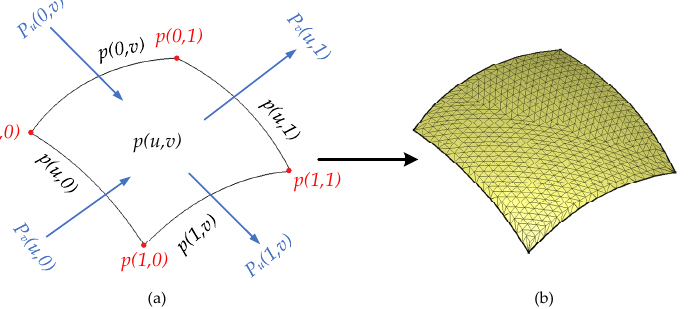
Figure 3. Schematic diagram of the interpolation of the bicubic Coons surface: ( a ) corner information, boundaries, and their cross-border tangent vectors of the surface patch; ( b ) the interpolated surface. After bringing Equation (2) into Equation (1) and simplifying it, we can obtain the simplified surface equation